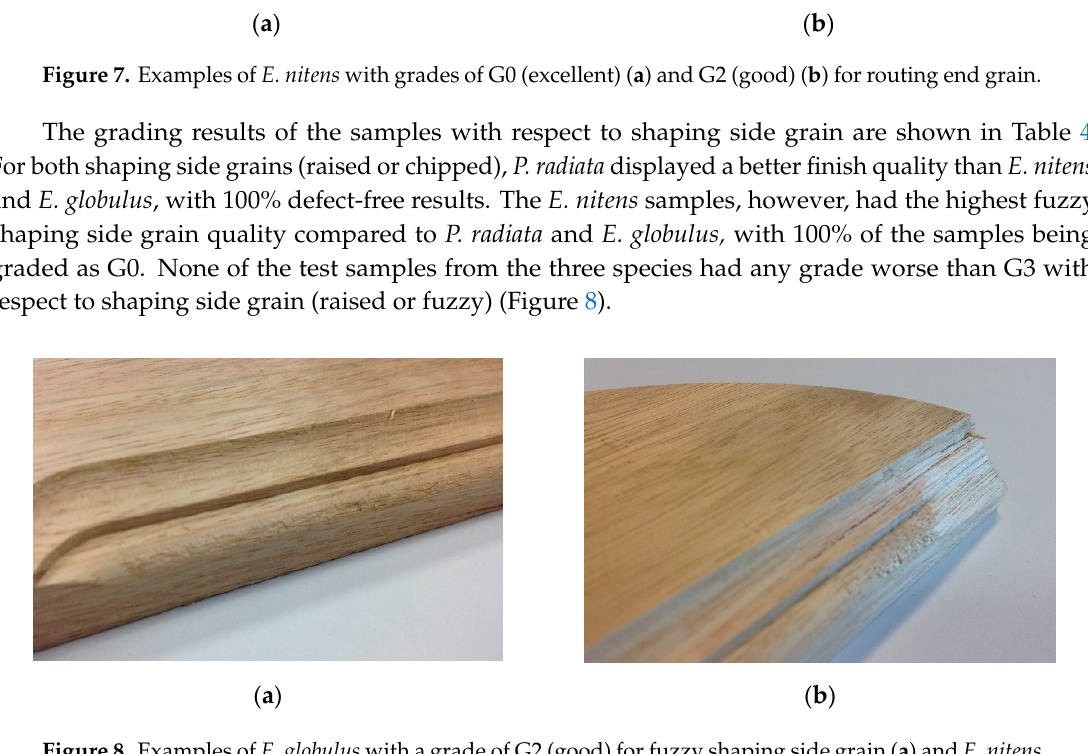
Figure 8. Examples of E. globulus with a grade of G2 (good) for fuzzy shaping side grain ( a ) and E. nitens with a grade of G5 (very poor) for chipped shaping side grain ( b ). Table 4. Grading results according to shaping side grain.